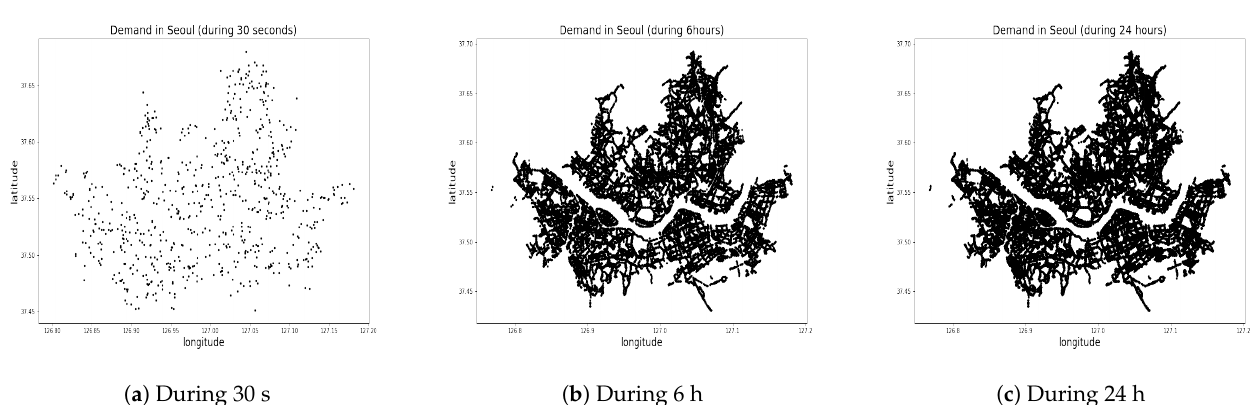
Figure 3. Illustration of demand during ( a ) 30 s (12:00:00 to 12:00:30 a.m.), ( b ) 10 min (12:00 to 12:10 a.m.), and ( c ) during